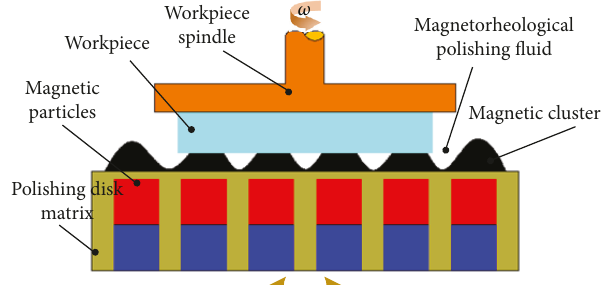
Figure 26: Cluster MRF